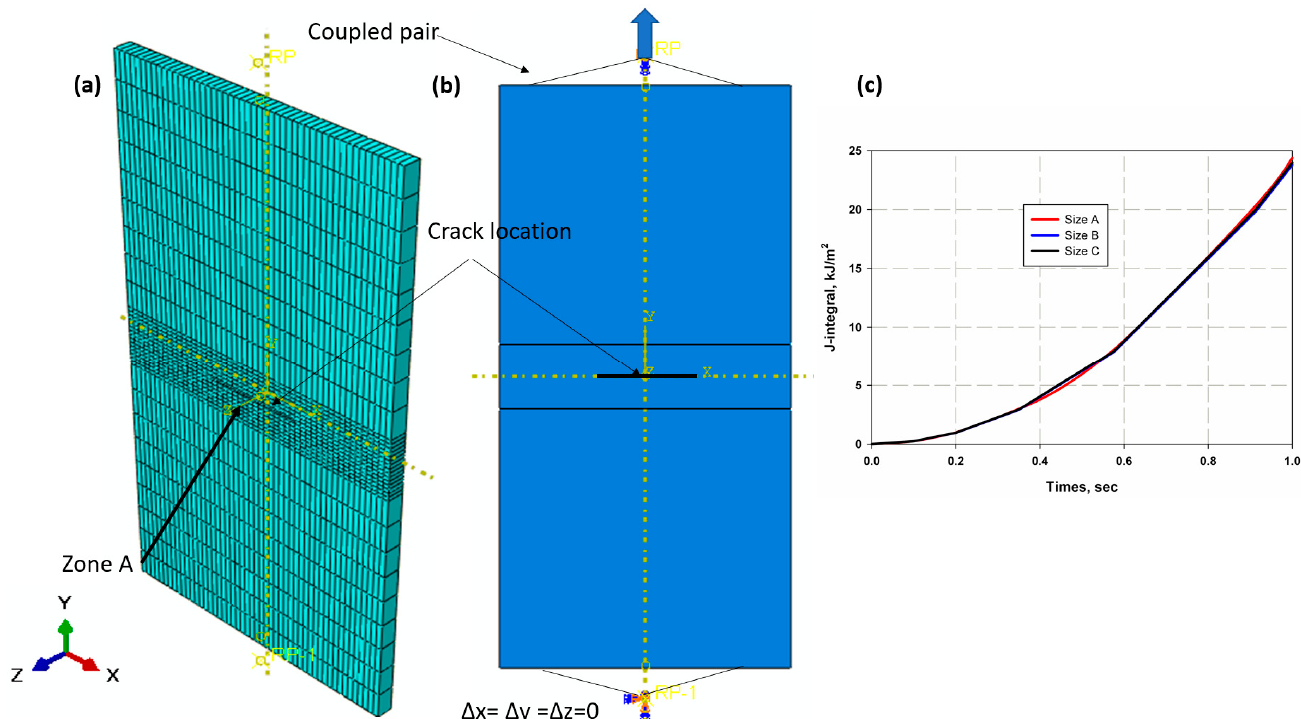
Figure 6. XFEM domain ( a ) mesh, ( b ) boundary condition and ( c ) mesh convergence.